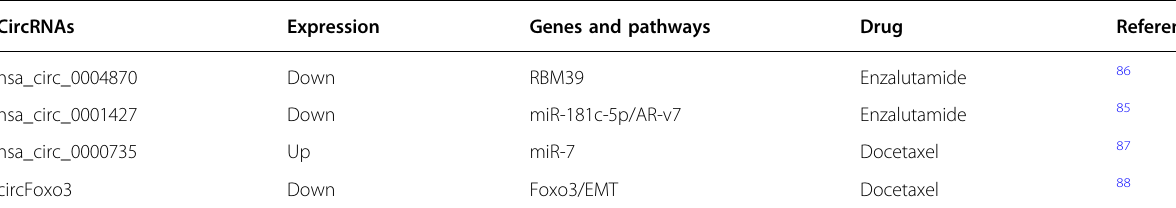
Table 5 CircRNA and drug resistance in prostate cancer.